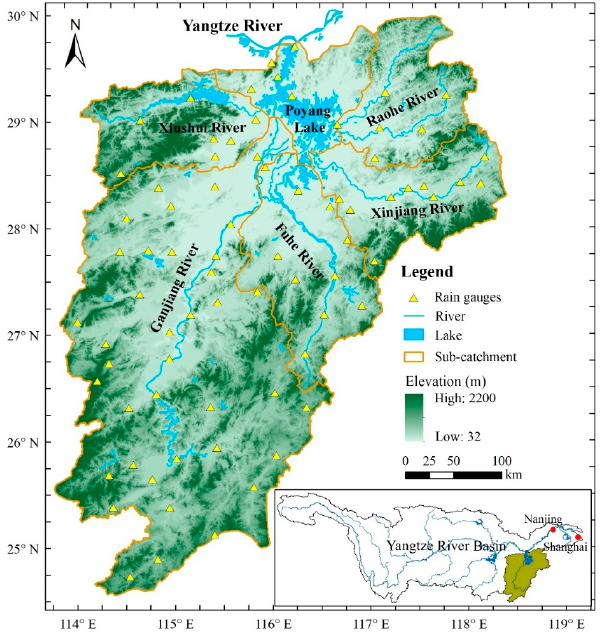
Figure 1. Location of the Poyang Lake Basin and distribution of the rain gauges.